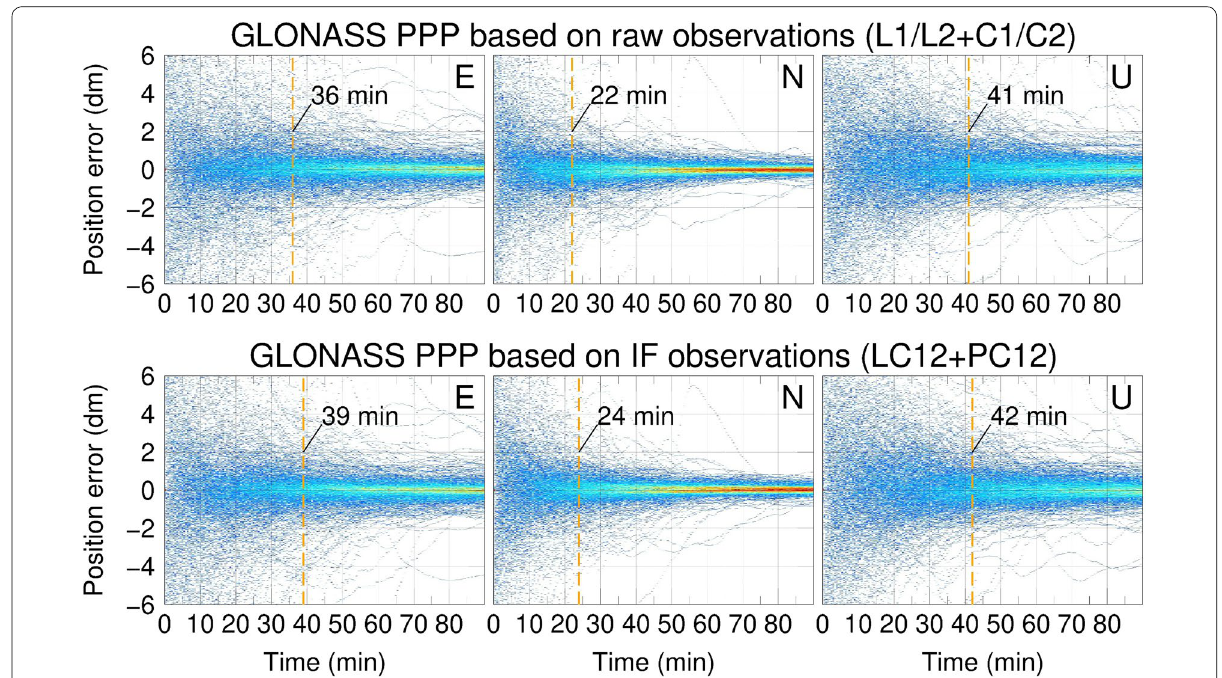
Fig. 6 Time series of positioning error for GLONASS PPP for the 96 stations in GPS week